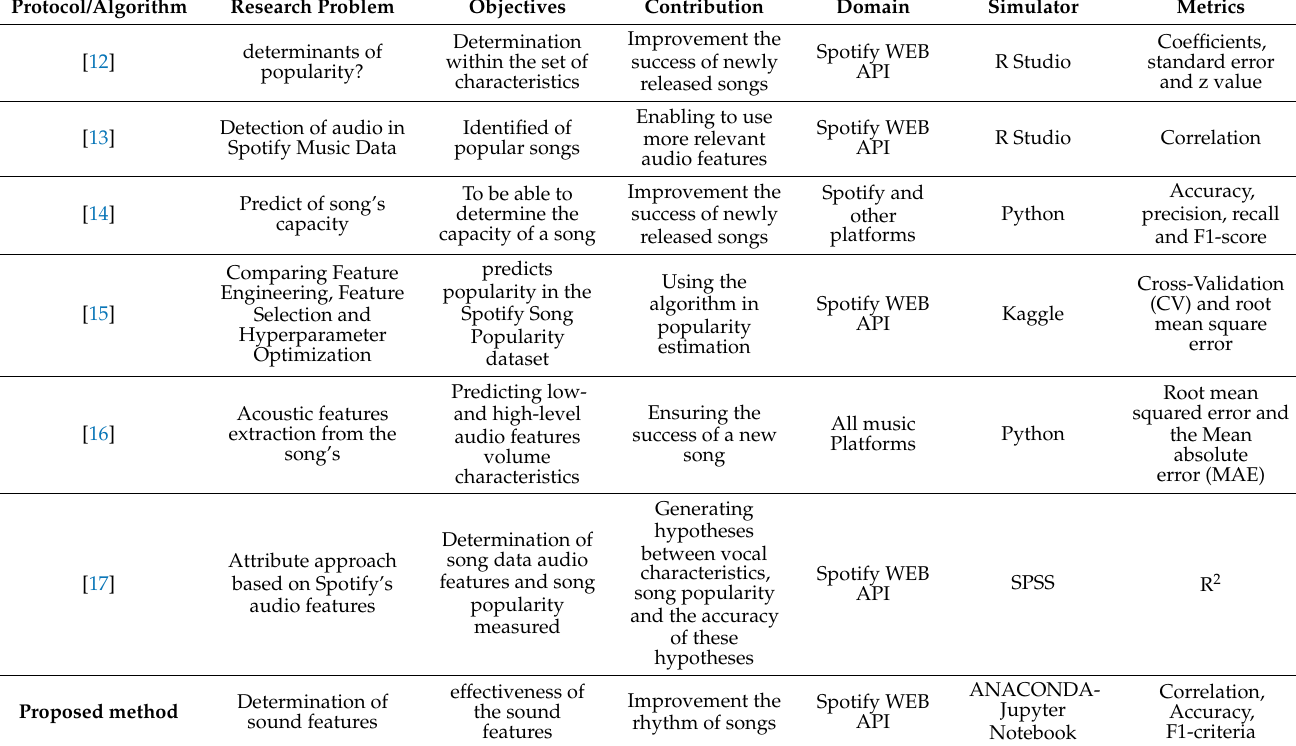
Table 1. Comparison of